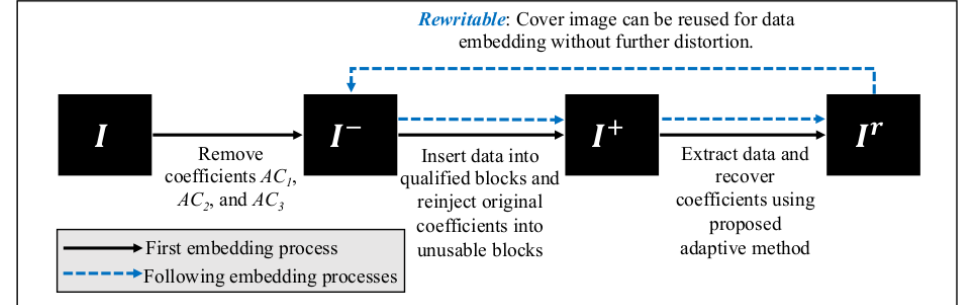
Figure 6. The rewritable process in the proposed